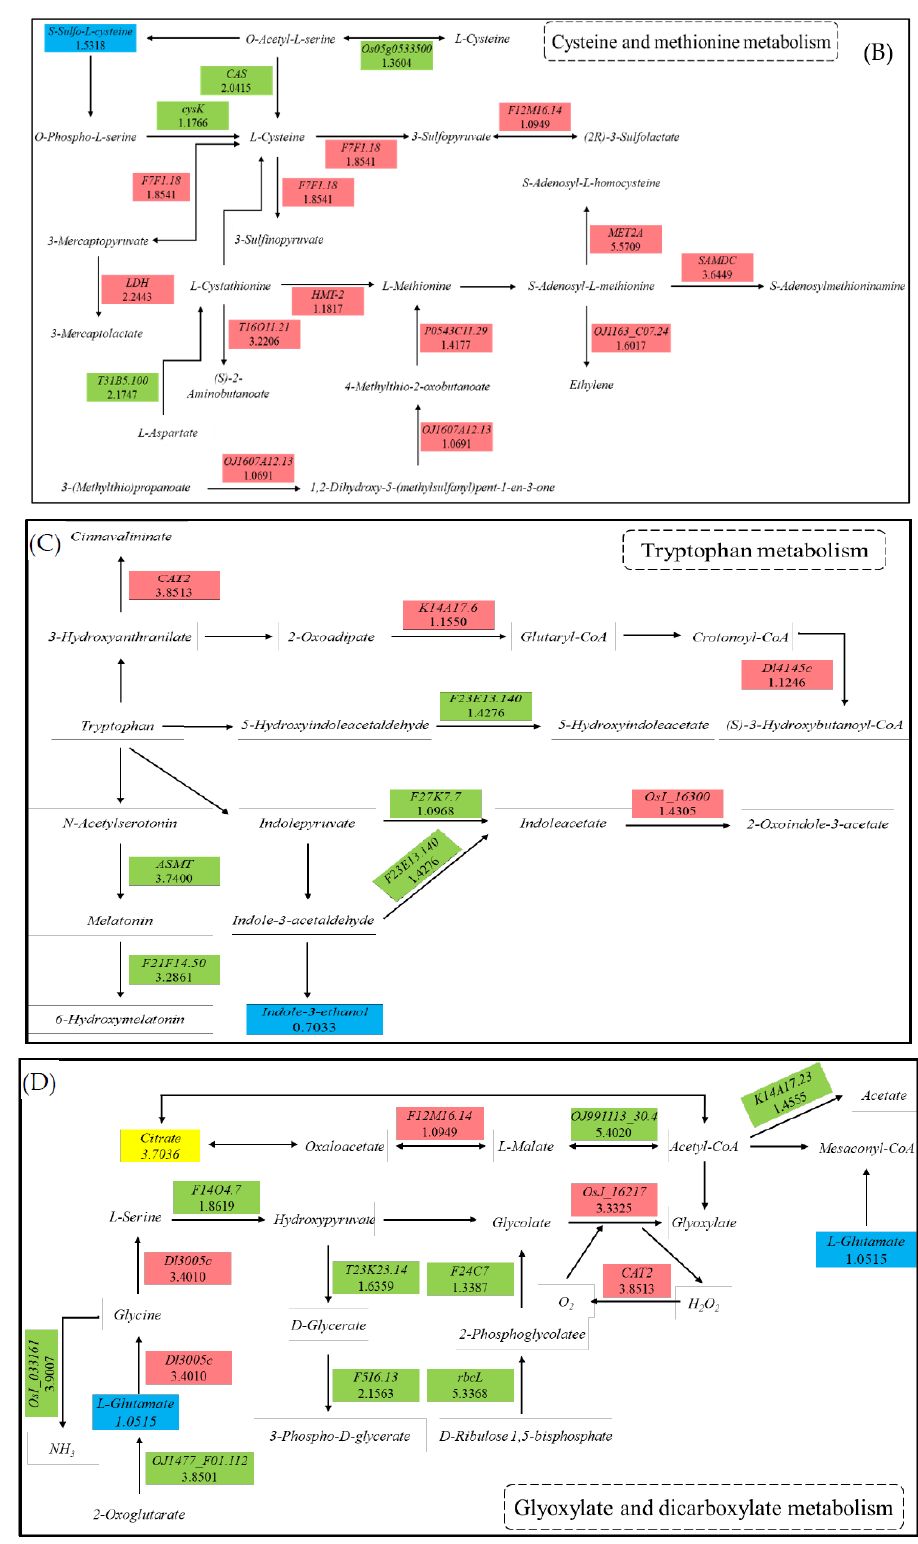
Figure 10. Networks of the ‘citrate cycle’ ( A ), ‘cysteine and methionine metabolism’ ( B ), ‘tryptophan metabolism’ ( C ), and ‘glyoxylate and dicarboxylate metabolism’ ( D ). The substances on the line are genes, and the locations of the nodes indicate metabolites. Red and green indicate upregulated and downregulated genes, respectively; yellow and blue indicate upregulated and downregulated metabolites, respectively.